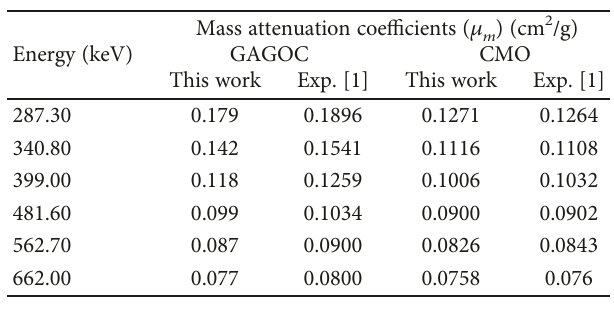
) for GAGOC and el